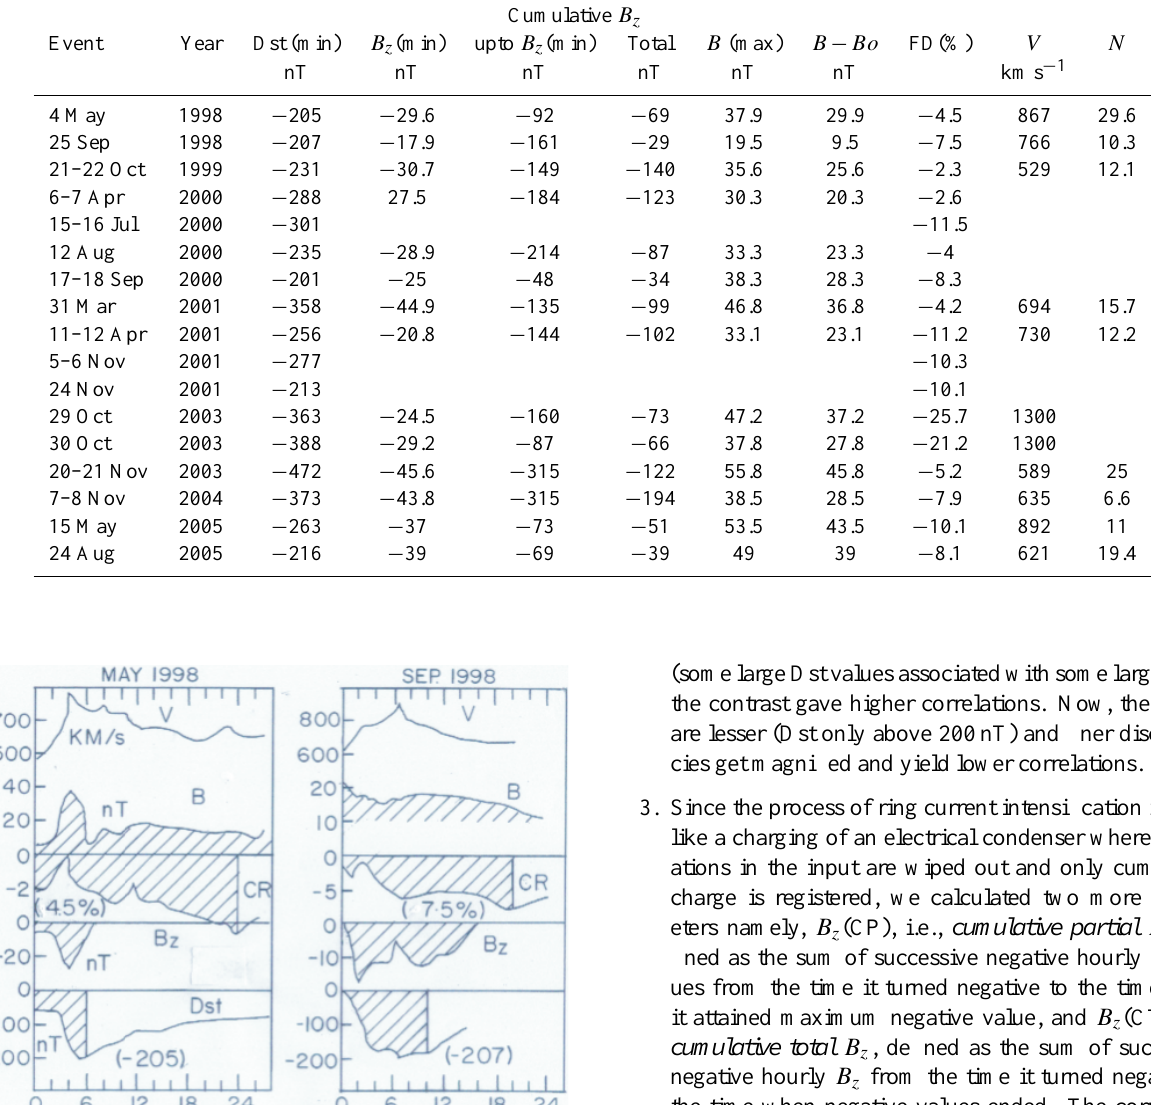
Table 2. Details of seventeen severe Dst events (numerically > 200nT) in cycle 23.